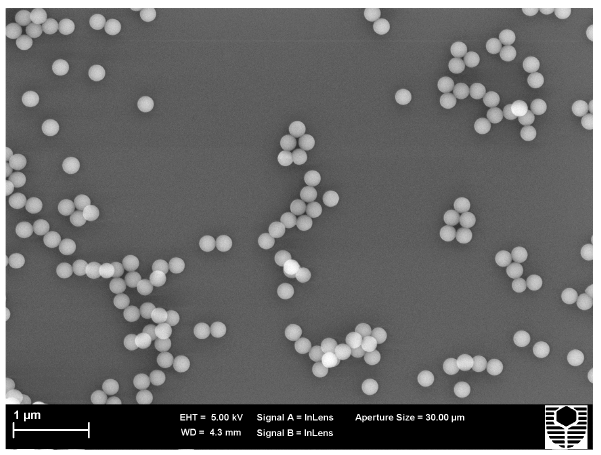
Figure 3. SEM image of PSL spheres from concentration method test on SiO 2 / SiO coated grid surface, concentrated from 1 to ∼ 667µgkg − 1 using TFF.